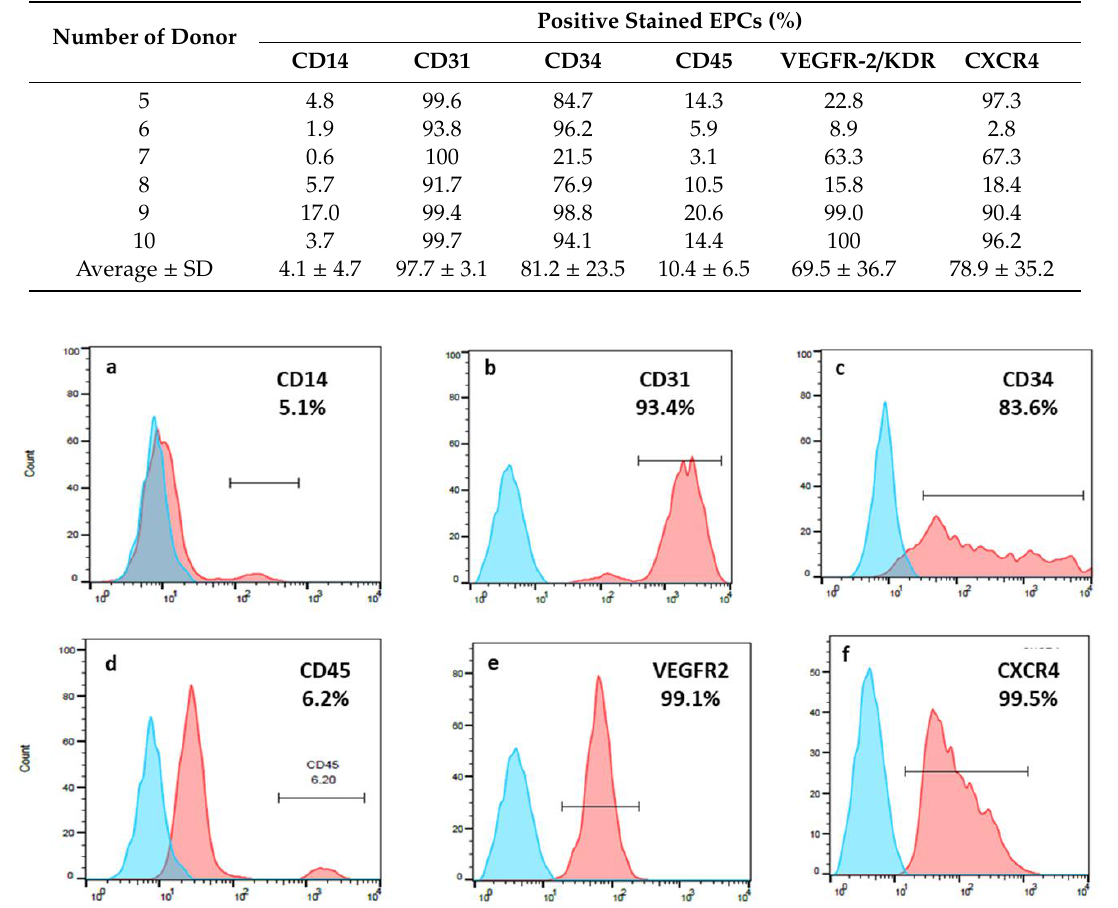
Figure 1. Flow cytometry analysis of primary EPCs: gated population of EPCs from donor 2, typical fluorescence in forward and side scatter, histogram representation includes unstained sample as a reference, revealing the percentage of positive stained cells.